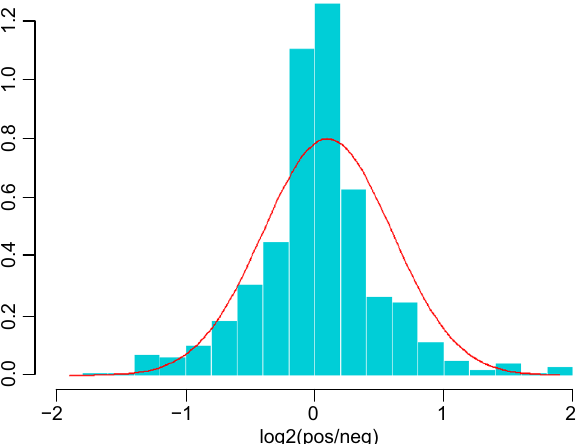
Figure 2. Histone ratio distribution of cases. The ratio distribution of the case group is roughly normal. It means that the protein levels have a high concentration around the mean value and the concentration decreases as the values move further away from the